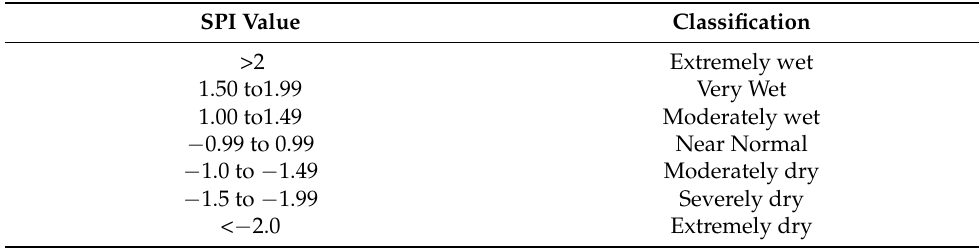
Table 1. Drought Classification as per SPI values (modified from